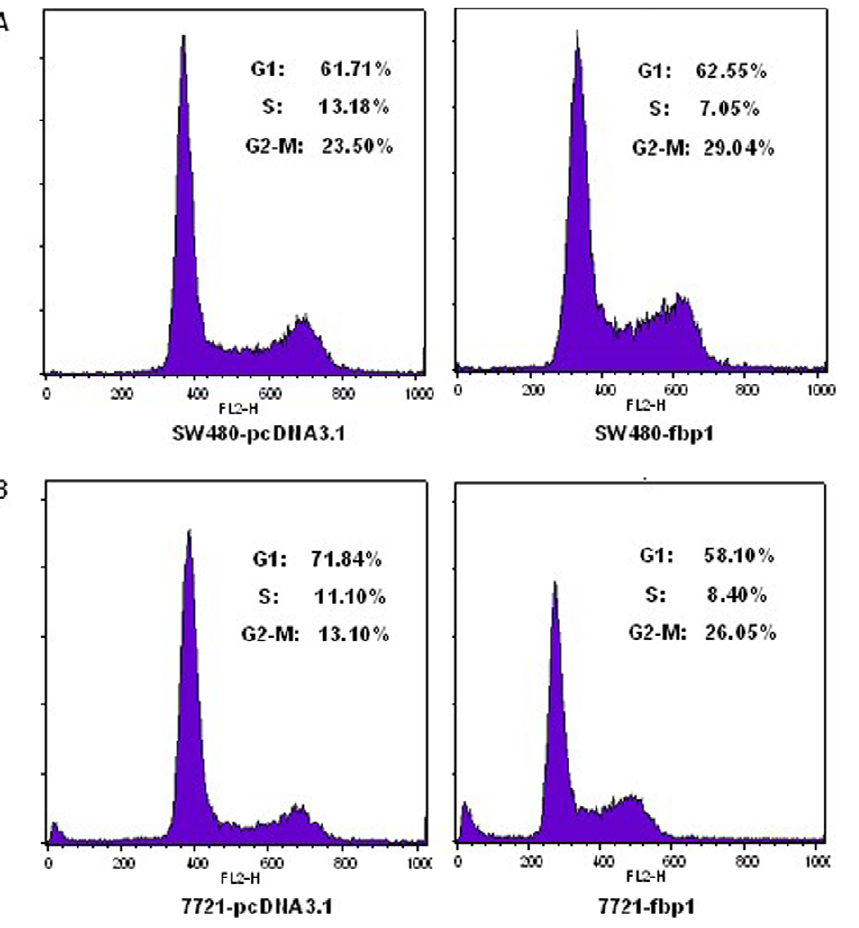
Figure 5. Effect of FBP1 on the cell cycle of liver and colon cancer cell line. The cell cycle distribution of liver and colon cancer cell line (SW480 and SMMC-7721) with and without FBP1 expression was evaluated by flow cytometry analysis. ( A ) and ( B ) Representative fluorescence - activated cell sorting analysis of cancer cells transfected with or without FBP1.